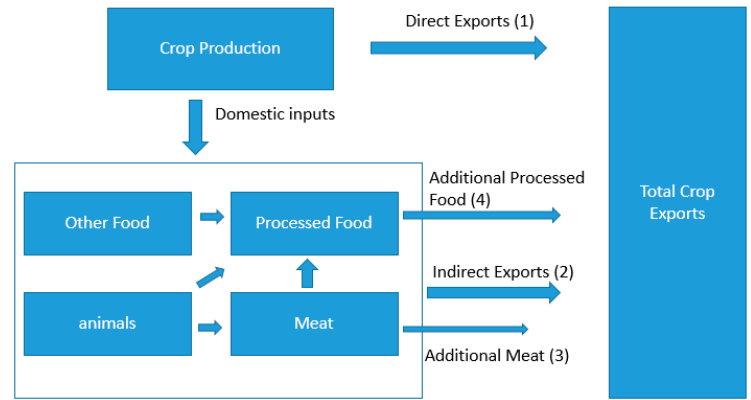
Figure 2. Total crop export including indirect exports from the noncrop sectors. The numbers in the brackets indicate the equation number that describes the corresponding product.